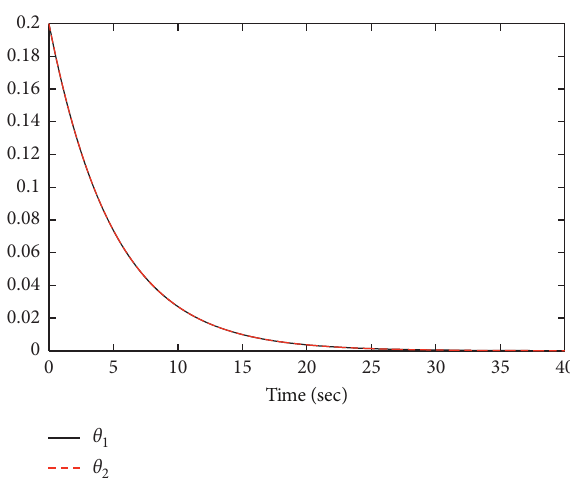
Figure 2: The response of the adaptive laws θ